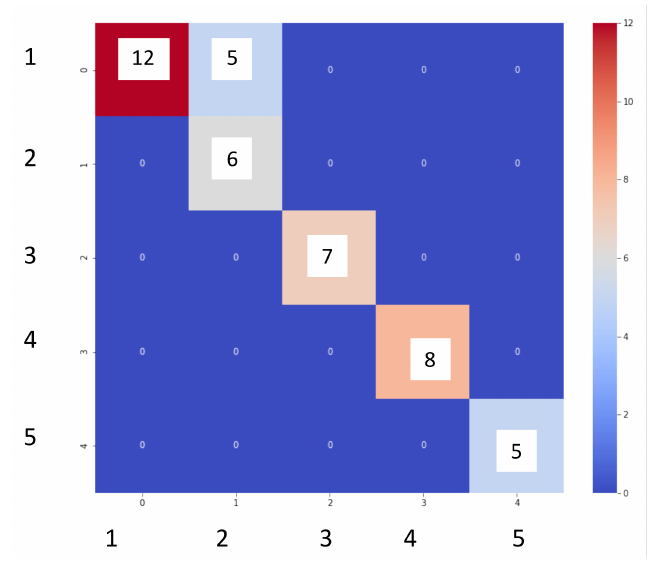
Figure 6. Confusion matrix for the decision tree method—pressure data.